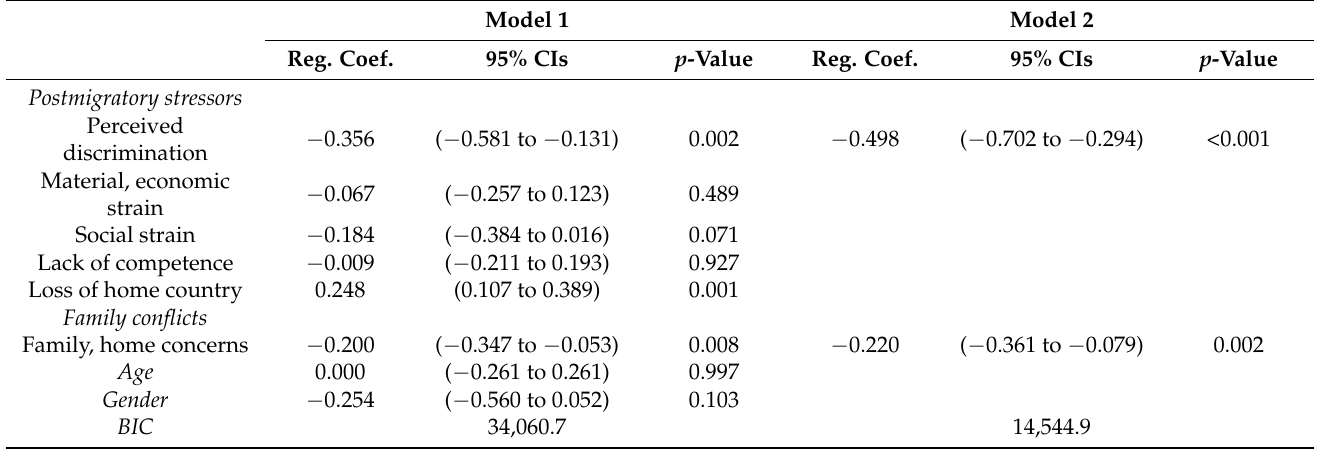
Table 3. Direct effect structural equation